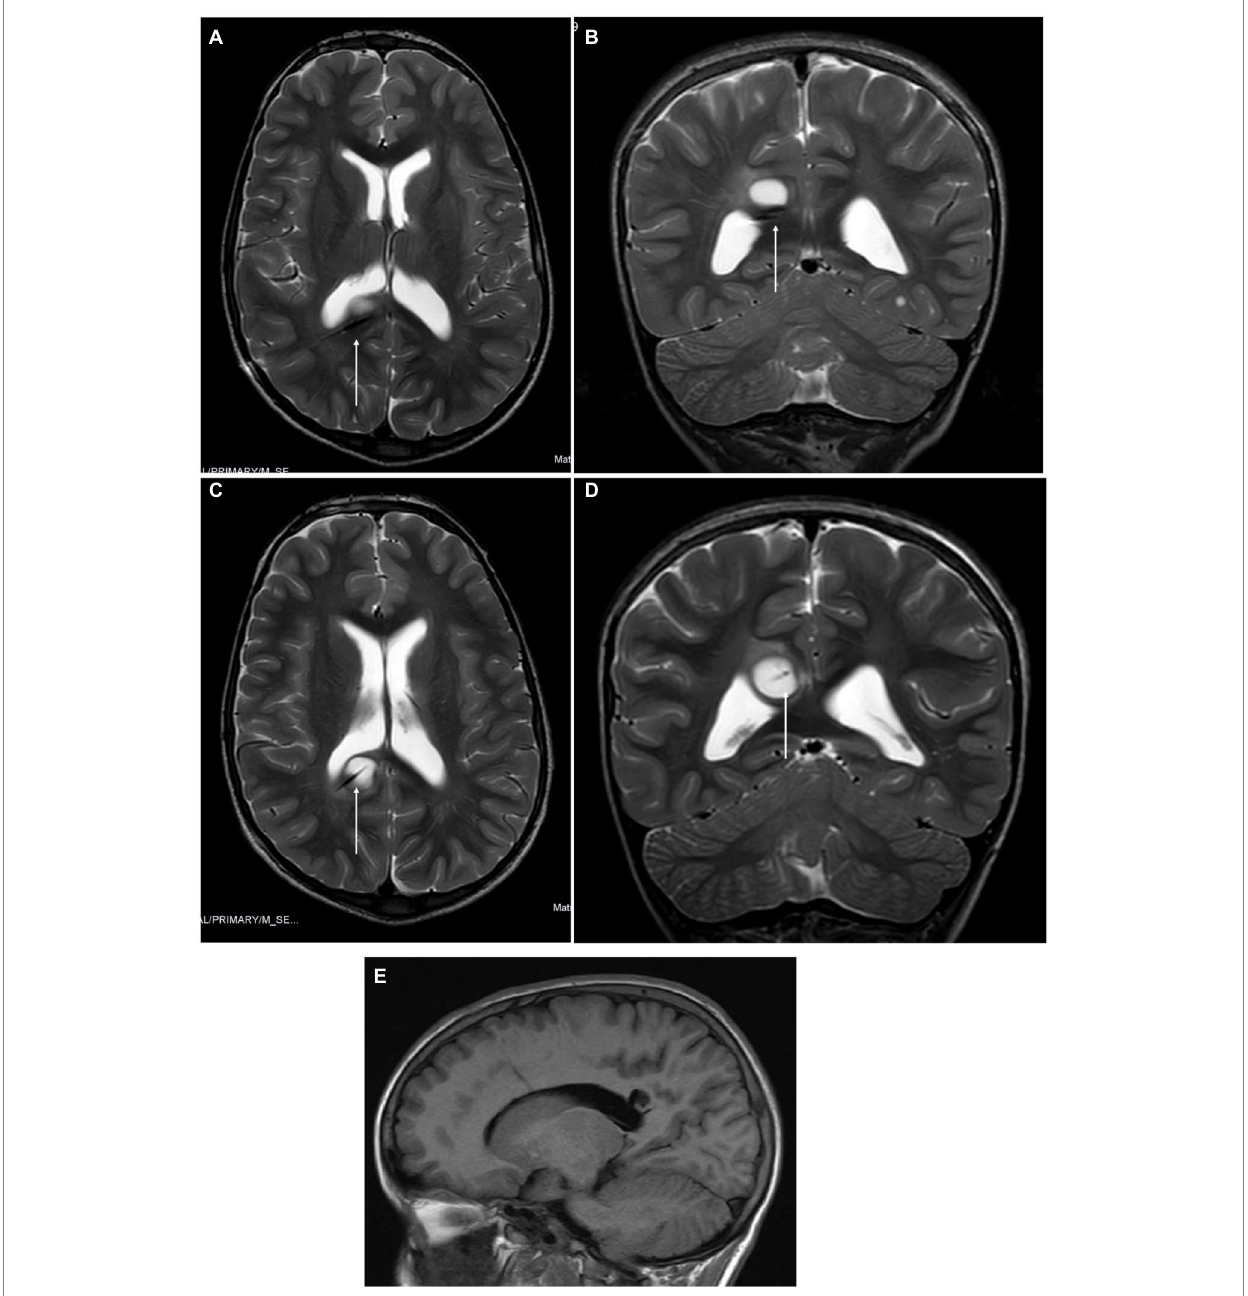
FIGURE 4 (A,B) Magnetic resonance imaging (MRI) revealed a suboptimal position of the tip of the laser diffusing fiber (LDF) on axial and coronal slices T2 sequences. No bleeding was detected. (C,D) MRI after repositioning the LDF before starting the procedure, with the tip on the middle of the right occipito-parietal tumor. (E) At the 21-month follow-up, the MRI scan revealed that the tumor had a cystic appearance and was filled with CSF. There was no evidence of contrast